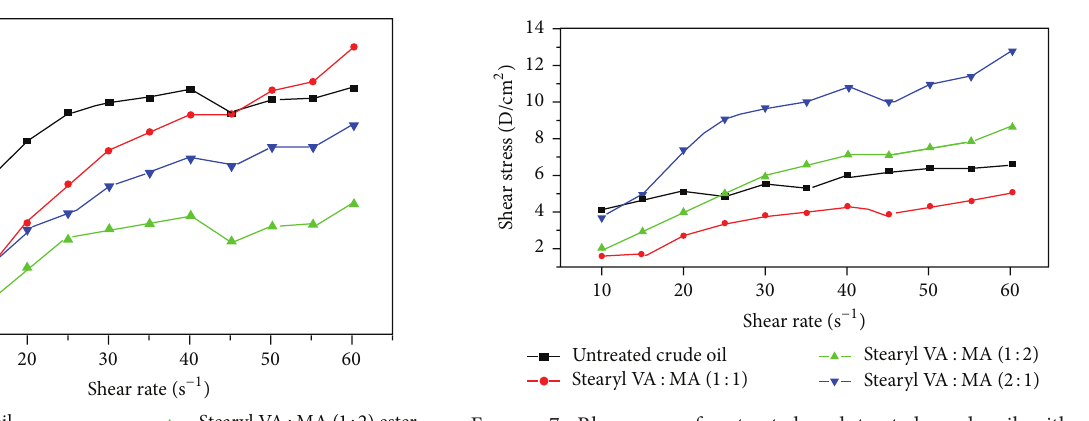
Figure 7: Rheogram of untreated and treated crude oil with 5000 ppm of different mol ratios at 15 ∘ C.